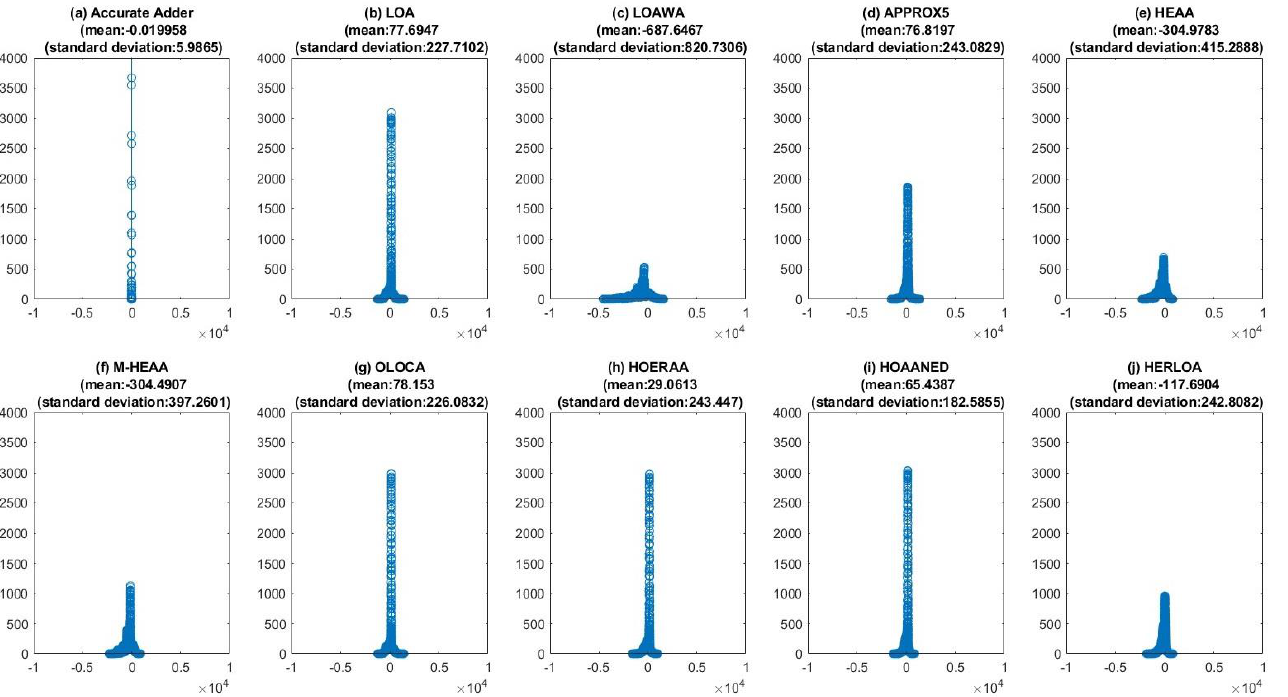
Figure 12. Plots showing the DPV between the Black Hole image compressed using accurate and approximate adders and the original Black Hole image, with the approximate adders having a 10-bit inexact part.